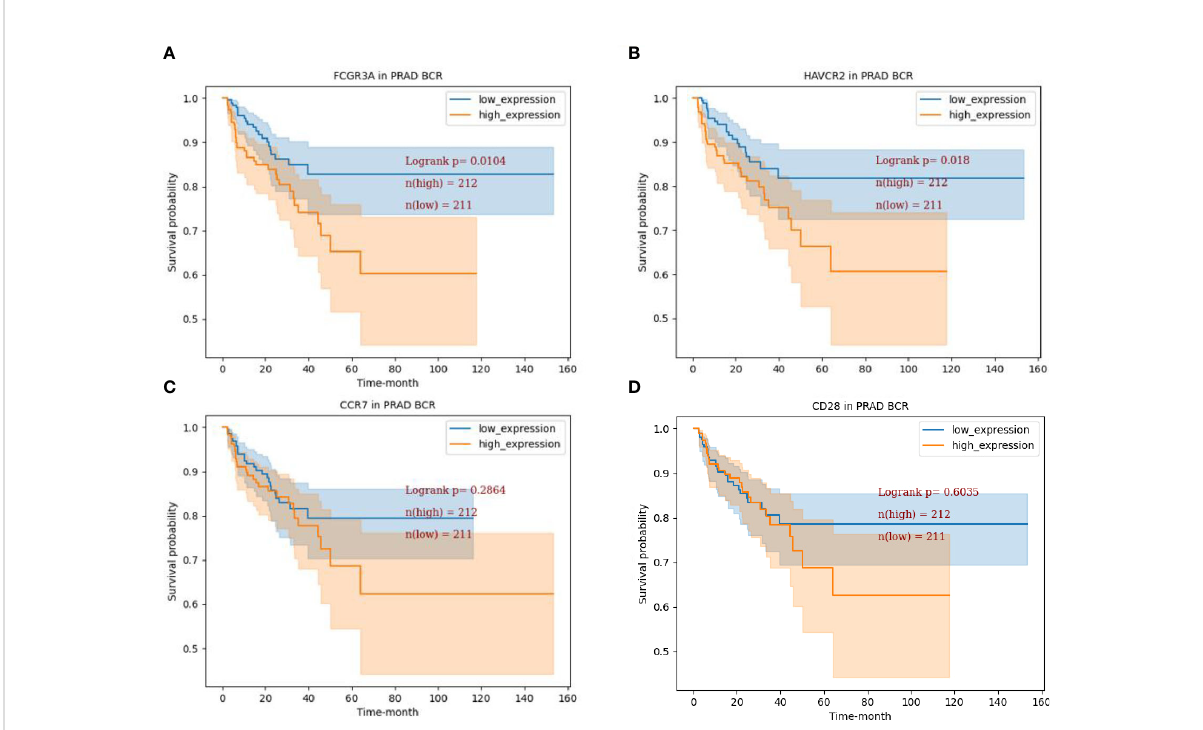
FIGURE 3 BCR free survival analysis of 4 target genes. (A) BCR free survival curve of FCGR3A in TCGA-PRAD dataset ( P =0.0104). (B) BCR free survival curve of HAVCR2 in TCGA-PRAD dataset ( P =0.0180). (C) BCR free survival curve of CCR7 in TCGA-PRAD dataset ( P =0.2864) (D) . BCR free survival curve of CCR7 in TCGA-PRAD dataset ( P